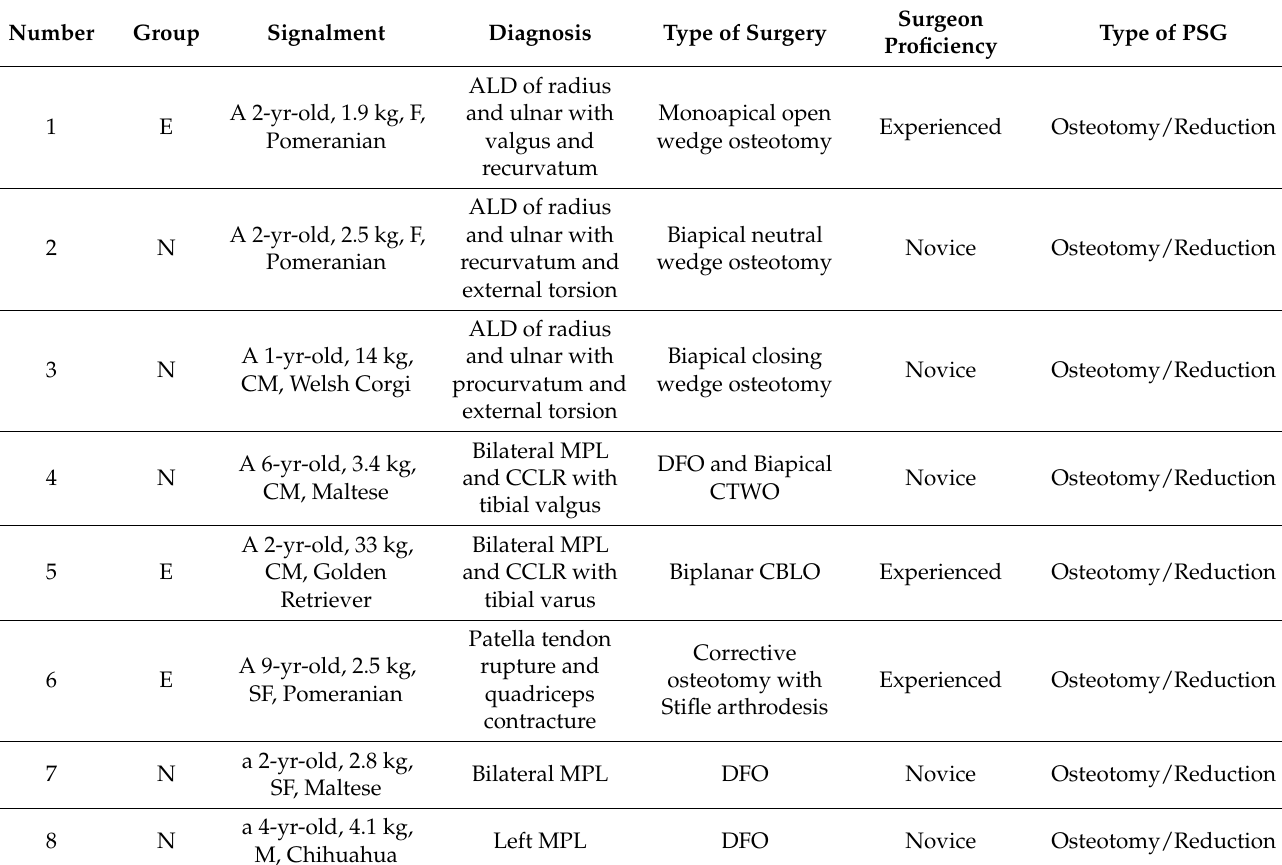
Table 1. Signalment, diagnosis, surgery, surgeon proficiency, and type of PSG in eight dogs undergoing surgical correction by 3D-printed patient-specific